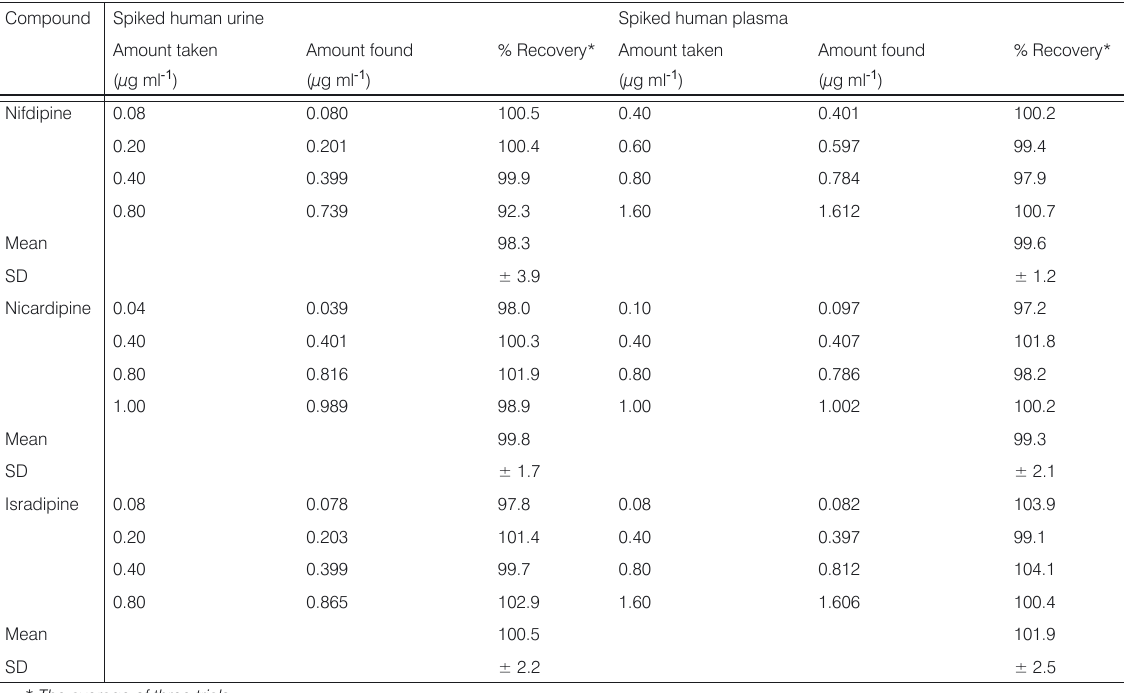
* The average of three